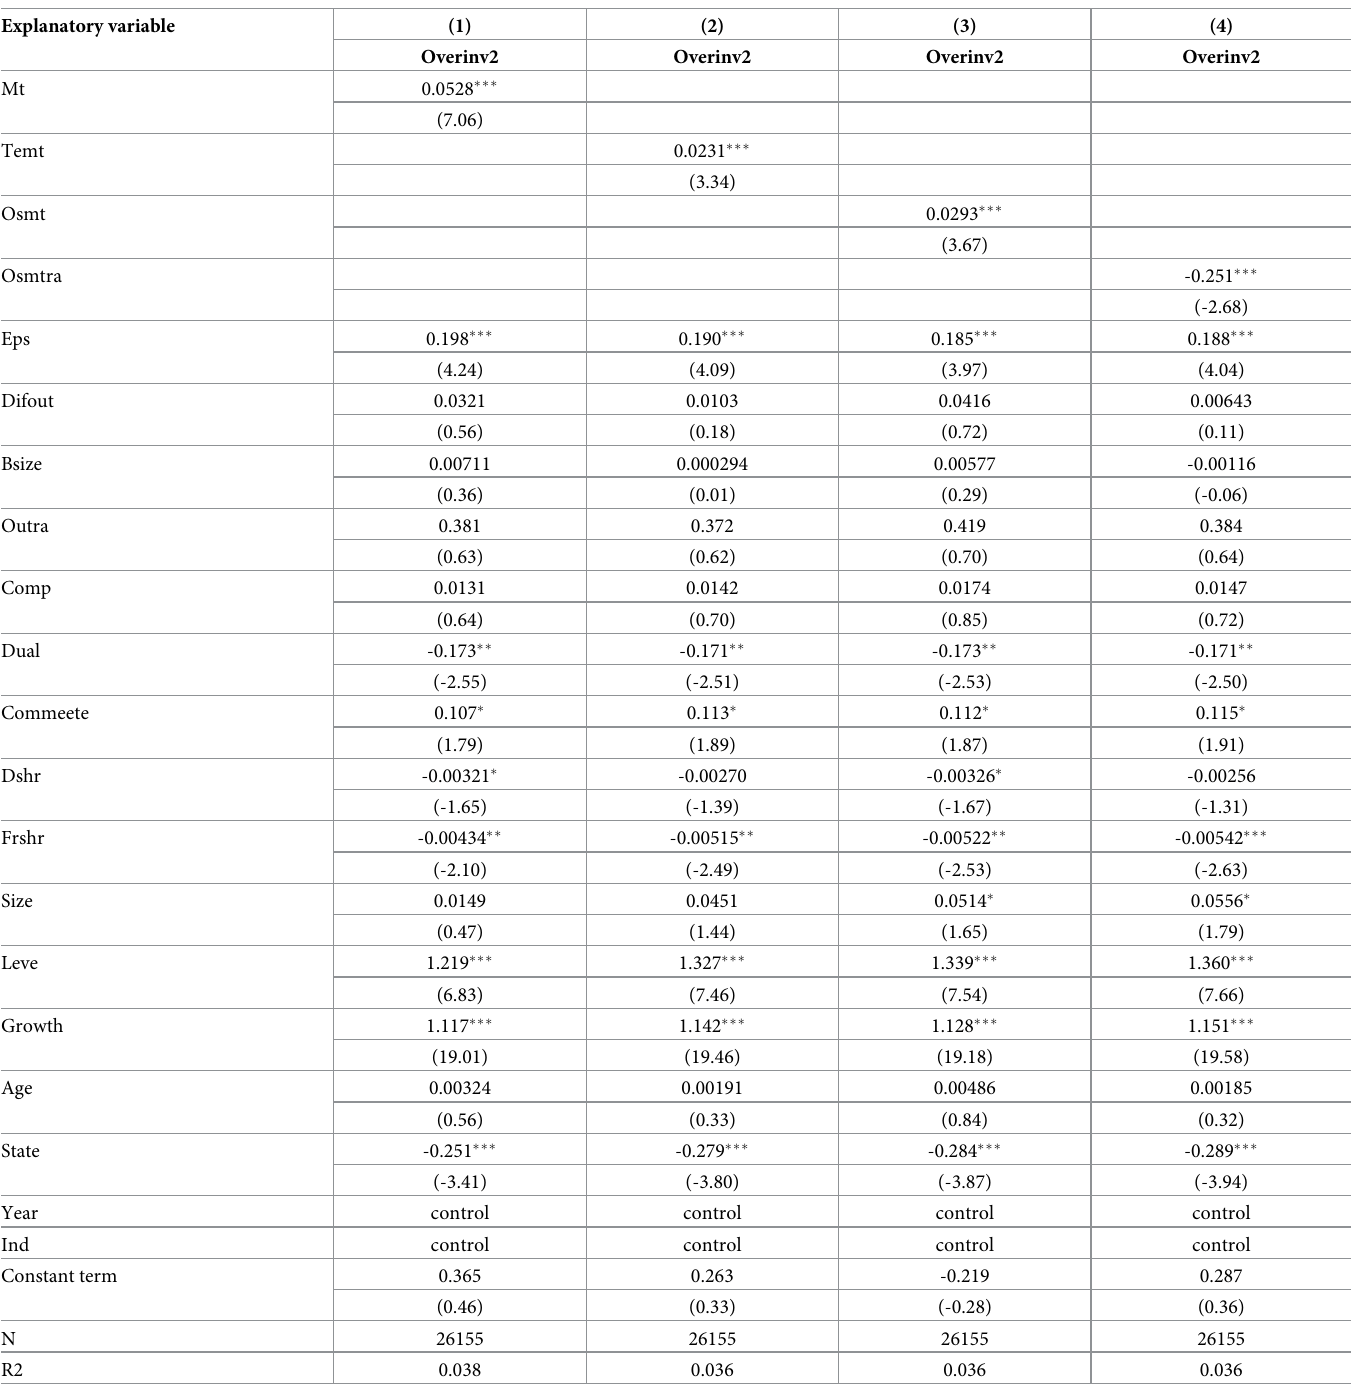
Table 8. The regression results of robustness